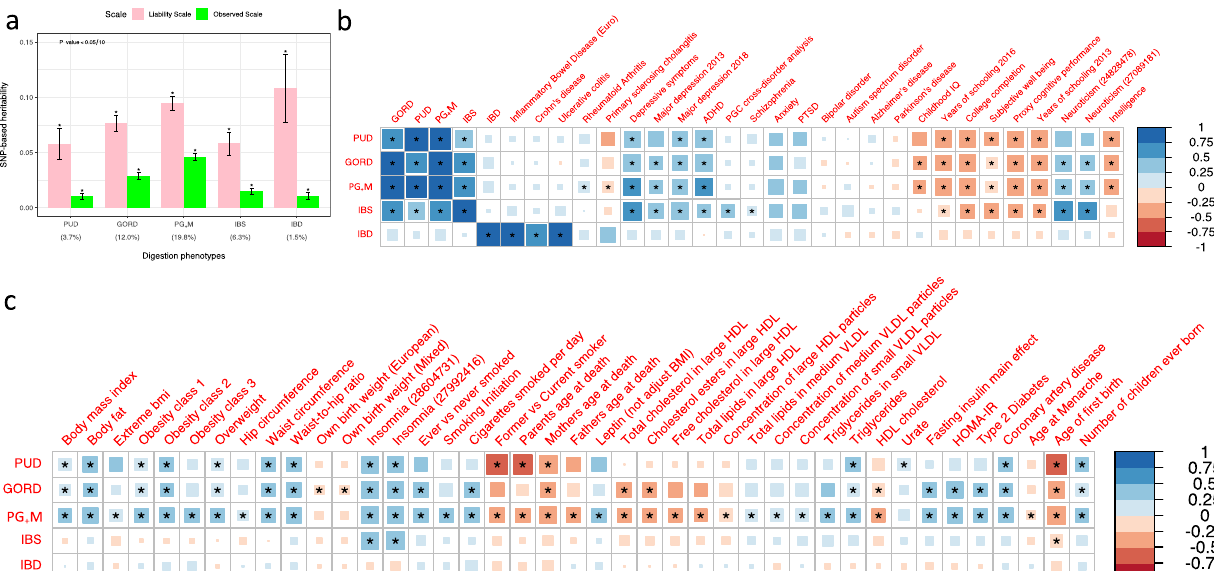
Fig. 4 SNP-based heritability and genetic correlation analyses for the fi ve digestion phenotypes from LD score regression analyses. a SNP-based heritability of the fi ve digestion phenotypes both on the observed and liability scales. The transformation to the liability scale uses the UKB sample risk, i.e., the proportion cases in the UKB cohort, as the population lifetime risk; the sample risk percentage of whole UKB European ancestry is shown below the x -axis in parentheses. The error bars represent 95% con fi dence interval for the estimated SNP-based heritability. “ * ” represents that the SNP-based heritability P value remain signi fi cant after Bonferroni correction ( P < 0.05/10). b , c Results for genetic correlation within-digestion phenotypes and between digestion phenotypes and the nine psychiatric and neurological disorder traits are in b , while genetic correlation results between digestion phenotypes and traits from LD Hub that had a signi fi cant correlation with at least one of the digestion phenotypes are provided in b , c . “ * ” represent that genetic correlation estimates are still signi fi cant after Bonferroni correction ( P < 0.05/((5 + 9 + 258) * 5)).